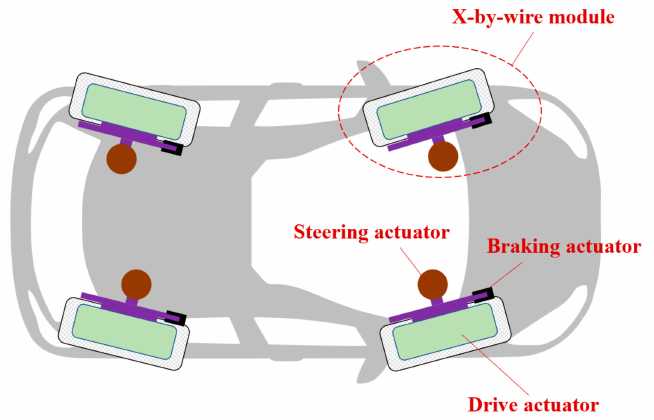
Figure 1. Chassis configuration of 4WID-4WIS EV.